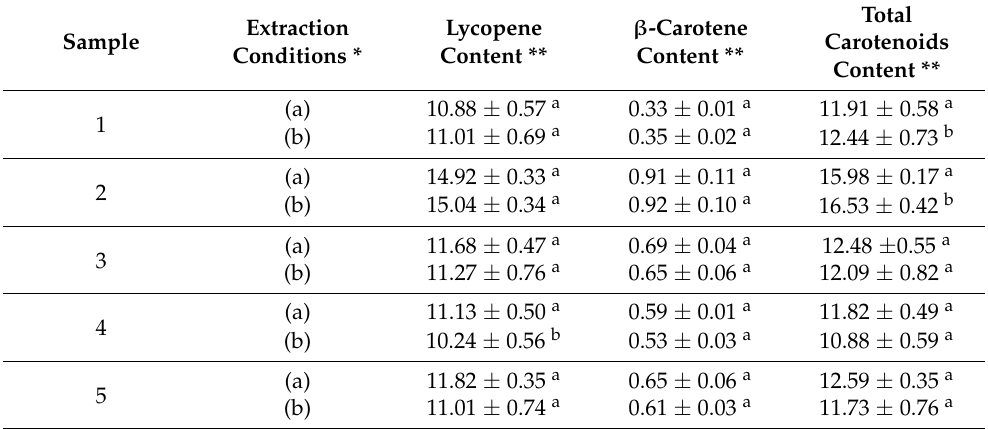
Table 4. Application of the optimised extraction conditions (i.e., duration; 62 min, solvent:solid ratio; 64:1, v / w ) to five randomly selected ripe tomato samples ( n = 3). Extraction Sample Conditions *